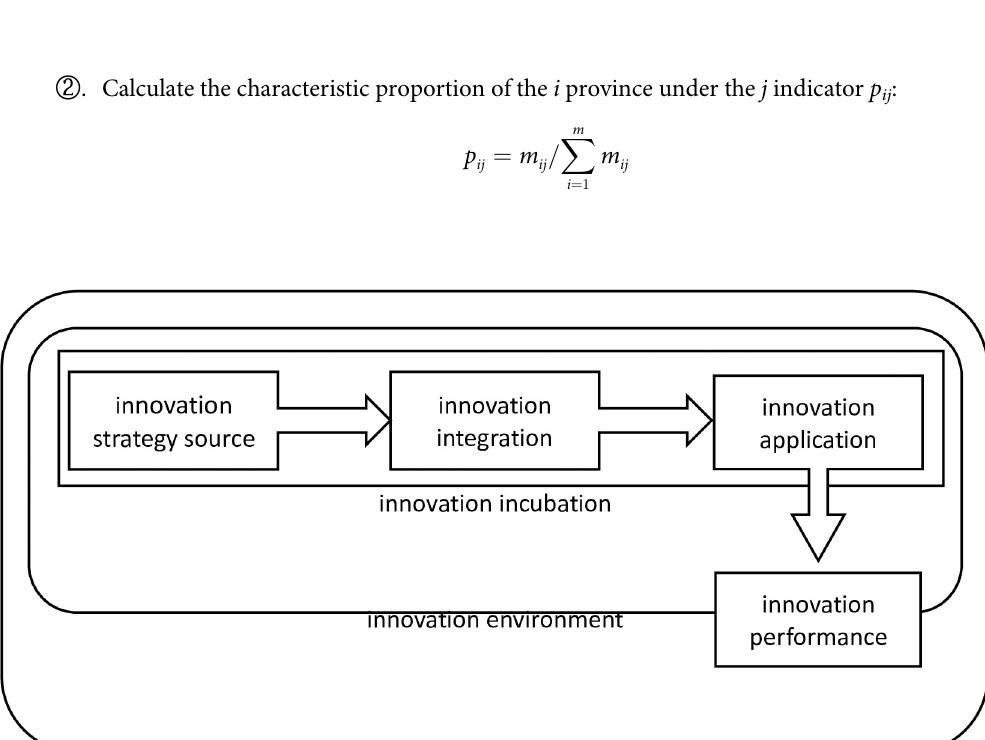
Fig 1. Endogenous and exogenous links of innovation